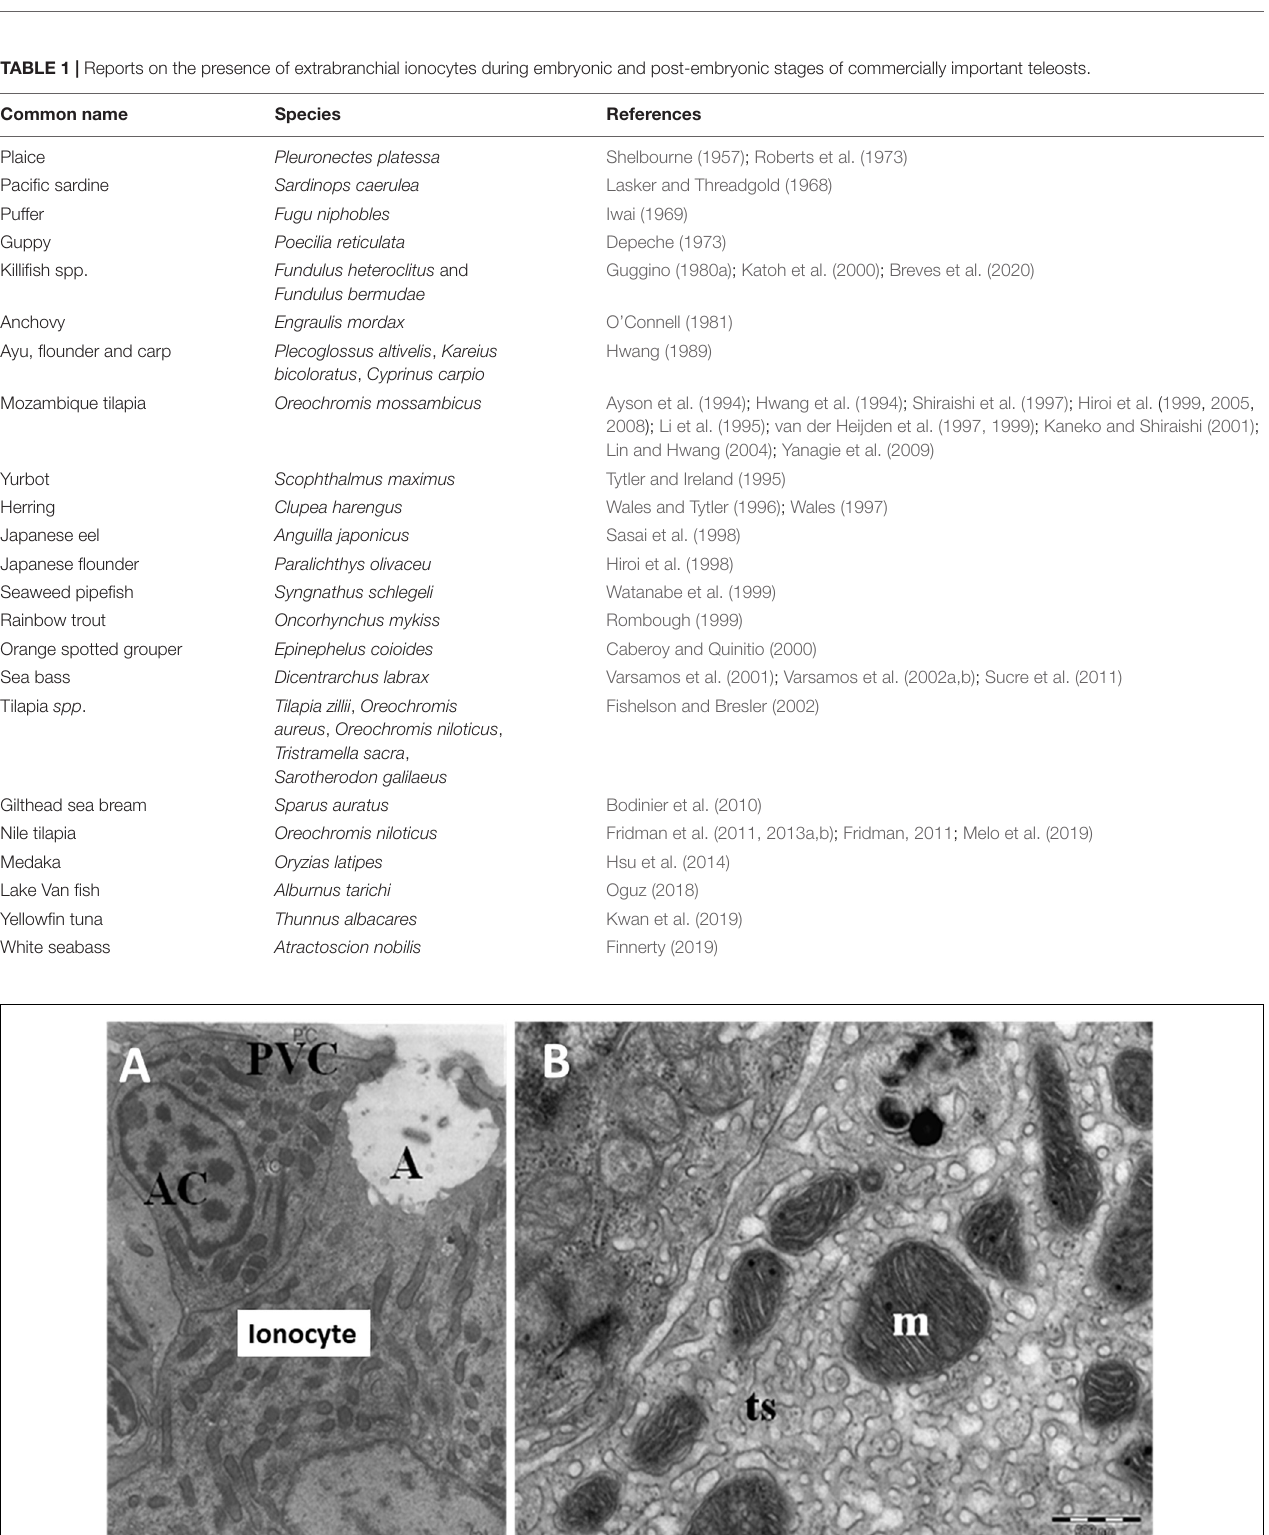
Frontiers in Marine Science |